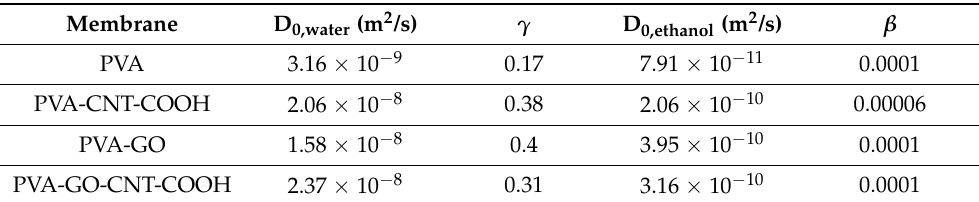
Table 3. Diffusion coefficients of Water (D 0,water ) and ethanol (D 0,ethanol ) through all the membranes at infinite dilution at 23 ◦